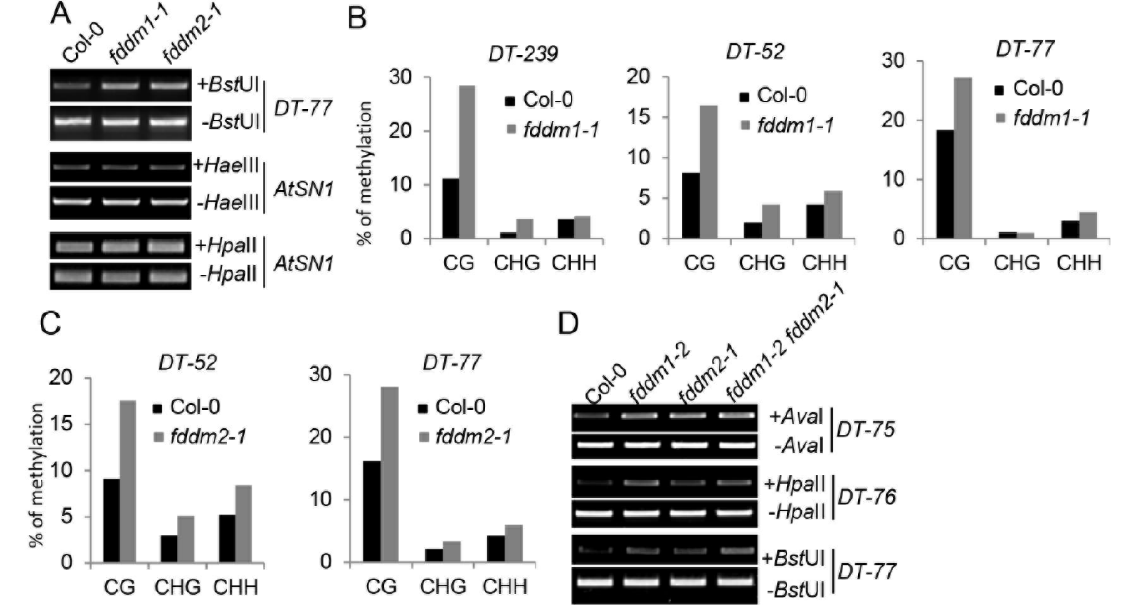
Figure 2. FDDM1 and FDDM2 are required for DNA demethylation. ( A ) FDDM1 and FDDM2 are required for DNA demethylation at the DT-77 locus. Hae III- or Hpa II-digested genomic DNAs were used for the PCR amplification of AtSN1 , while Bst UI-treated genomic DNAs were used for the amplification of DT-77 . Undigested genomic DNAs are used as loading controls. ( B , C ) The bisulfite sequencing analyses of DNA methylation at various genotypes. The percentage of methylated cytosine in different cytosine contexts is shown. ( D ) FDDM1 and FDDM2 do not act redundantly in DNA demethylation. Restriction enzyme-digested and undigested (loading control) DNAs were used as templates for the PCR amplification of various